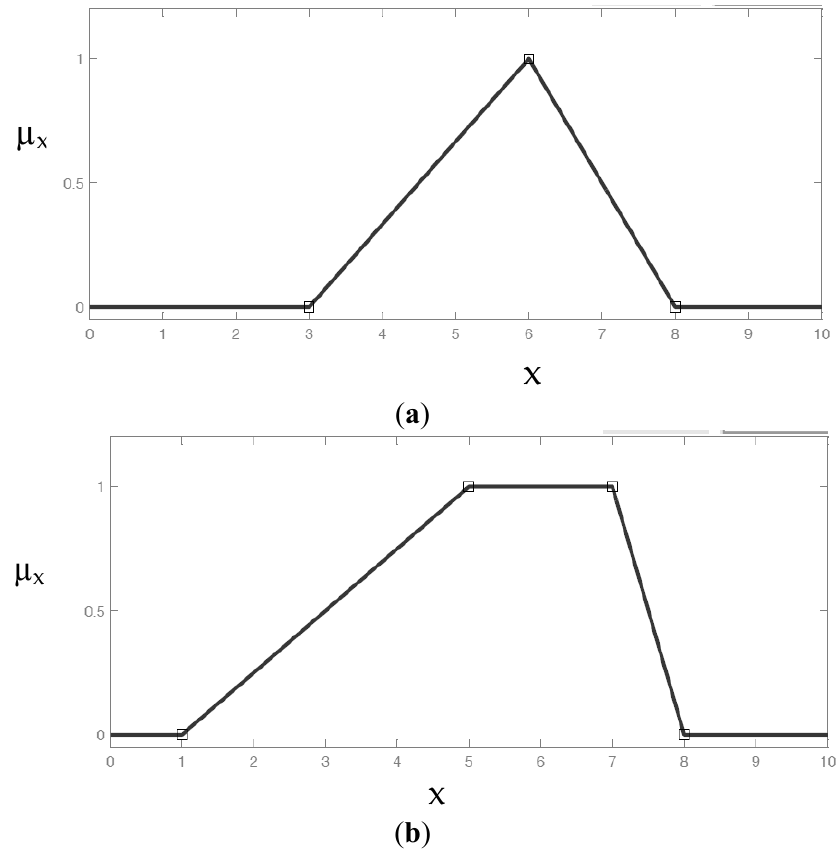
Figure 6. ( a ) Triangular membership function; ( b ) Trapezoidal membership